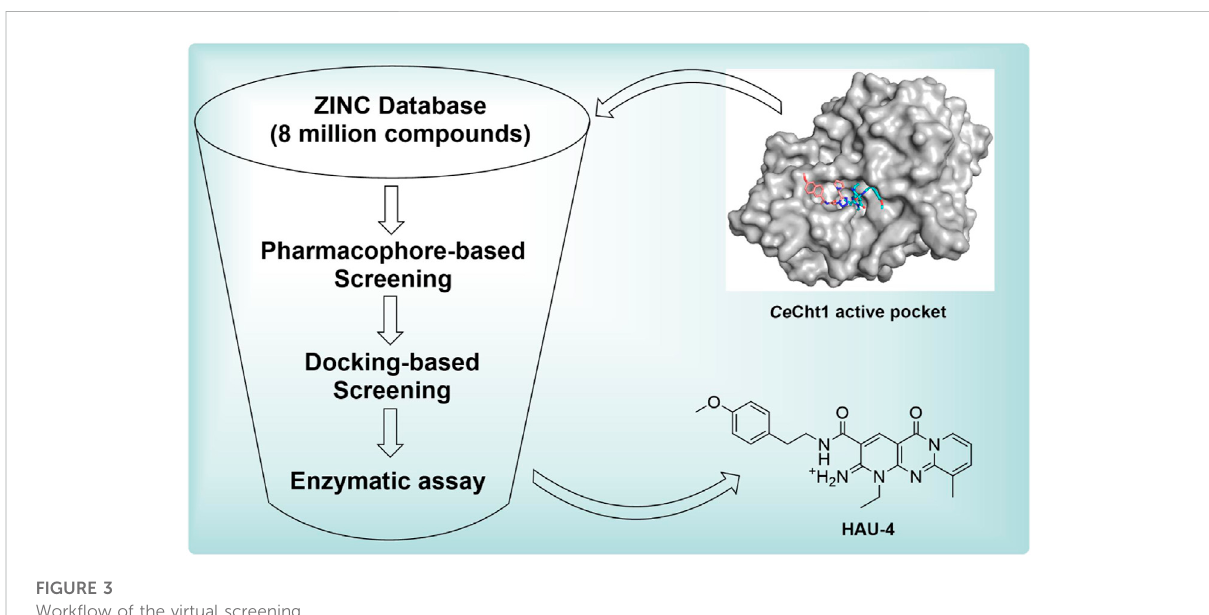
FIGURE 3 Work fl ow of the virtual